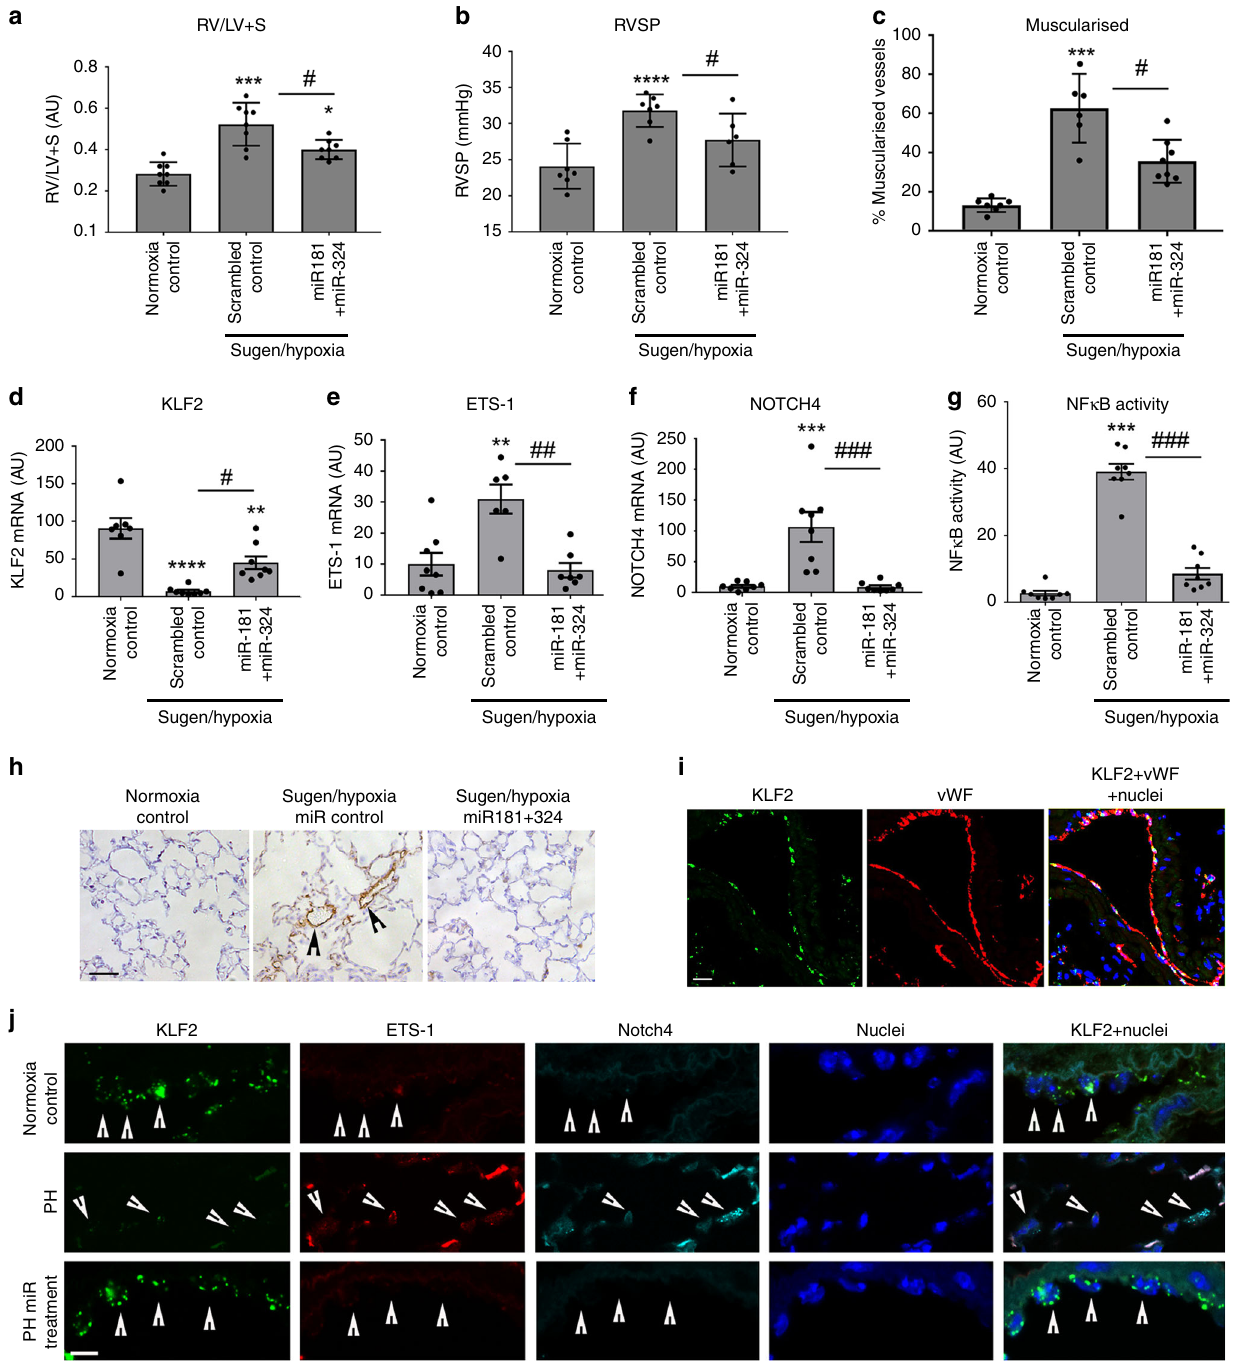
Fig. 8 Delivery of miR181 and miR-324 attenuates pulmonary hypertension and reduces expression of Notch4, ETS-1 and NF κ B activity in Sugen/ hypoxia mice. a Right ventricular hypertrophy (RV/LV + S), b RVSP, and c vascular muscularisation in mice treated, as indicated. Changes in d KLF2, e ETS-1, f Notch4 mRNA levels, and g NF κ B activity (nuclear localisation) in the lungs of Sugen/hypoxia mice; fl uorescence (arbitrary units). ** P < 0.01, *** P < 0.001, **** P < 0.0001, comparison with untreated controls; # P < 0.05, ## P < 0.01, ### P < 0.001, comparisons as indicated. Values are means ± s.e.m. One-way ANOVA with Tukey post-test. h Representative images of α -SMA staining in the untreated and miR-181 + miR-324-treated mice lungs. i Co- localisation of KLF2 mRNA with vWF in mouse lung endothelium. j KLF2, ETS-1, Notch4 mRNA and nuclei in lung endothelial cells from healthy, pulmonary hypertensive (PH) and miRNA-treated mice, as indicated. Fluorescent in situ hybridisation, confocal microscopy. Each fl uorescent dot corresponds to a single transcript; arrowheads point to endothelial cells. In h , i bar = 25 µ m and in j bar = 10 µ m. In a n = 8, b n = 6 – 7, c n = 6 – 8, d n = 7 – 8, e n = 6 – 8, f n = 7 – 8, g n = 8 of biologically independent samples. Source data are provided in Source Data fi